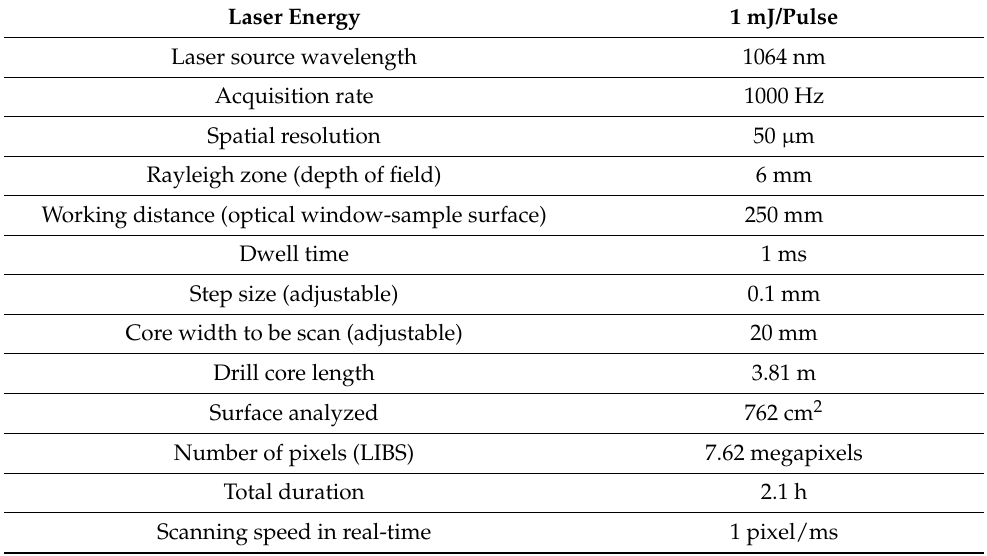
Table 2. ECORE LIBS analysis principal